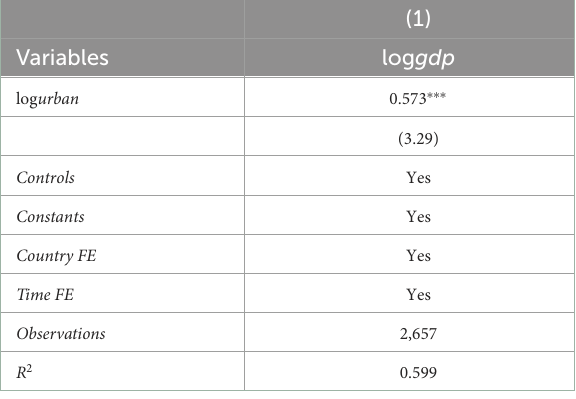
TABLE 9 Effect of urbanization on the potential